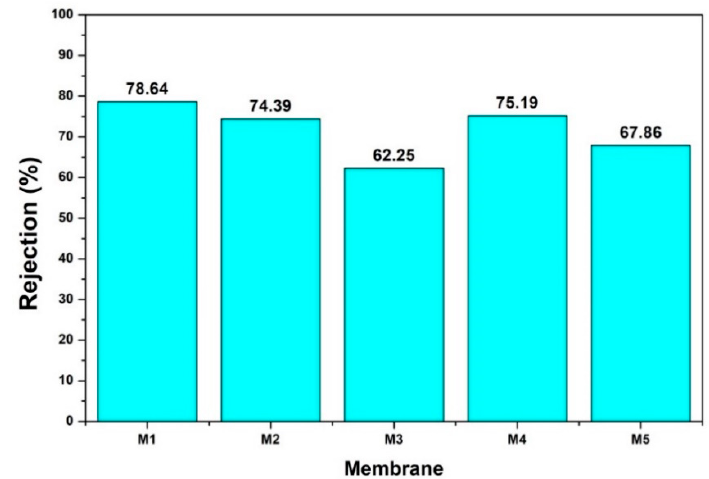
Figure 7. Humic Acid (10 ppm) rejection of PES membranes without and with addition of silica from rice husk and sugarcane bagasse of different concentrations. Filtrations were conducted at transmembrane pressure of 3.5 bar.